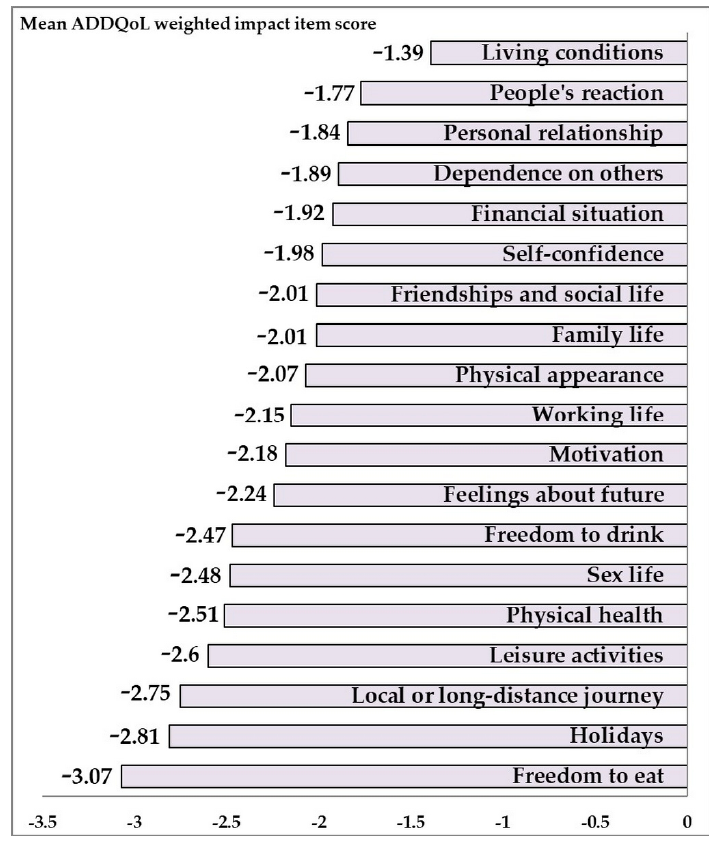
Figure 2. The mean weighted impact (ADDQoL scores) of diabetes on individual life domains in the population study.